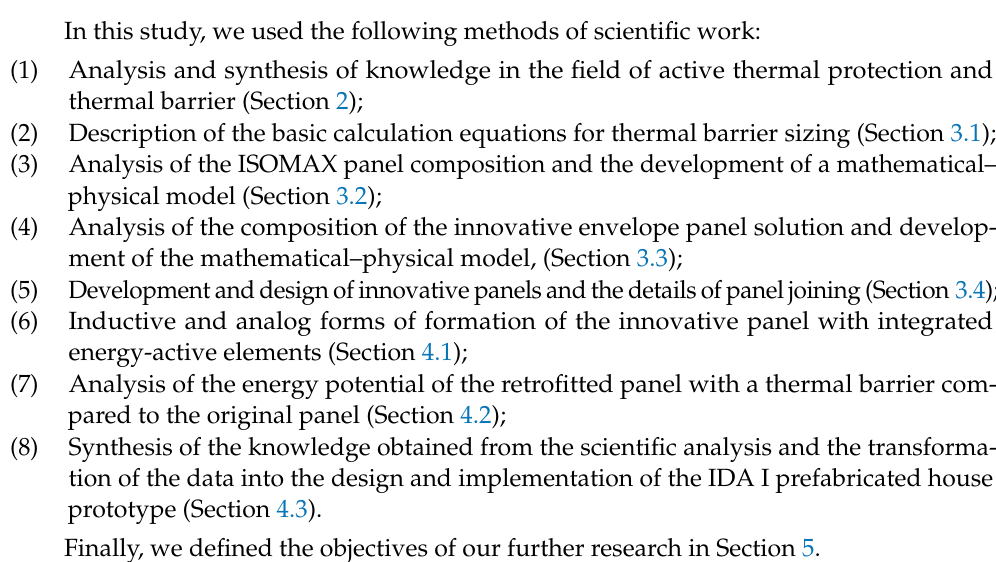
Figure 2. View of ISOMAX panel production from lost formwork